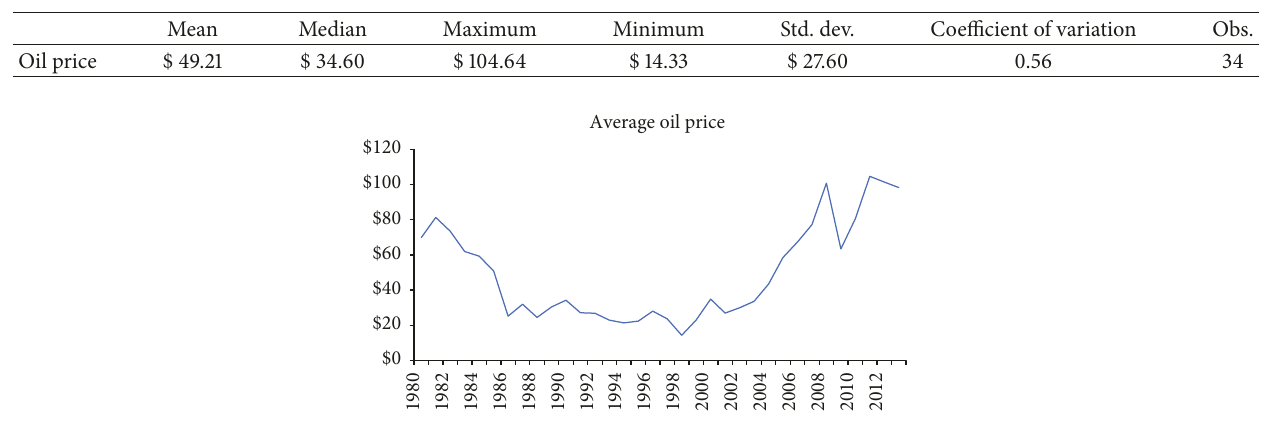
Table 2: Average annual oil price statistics in USD/barrel, deflated to 2013 dollars.